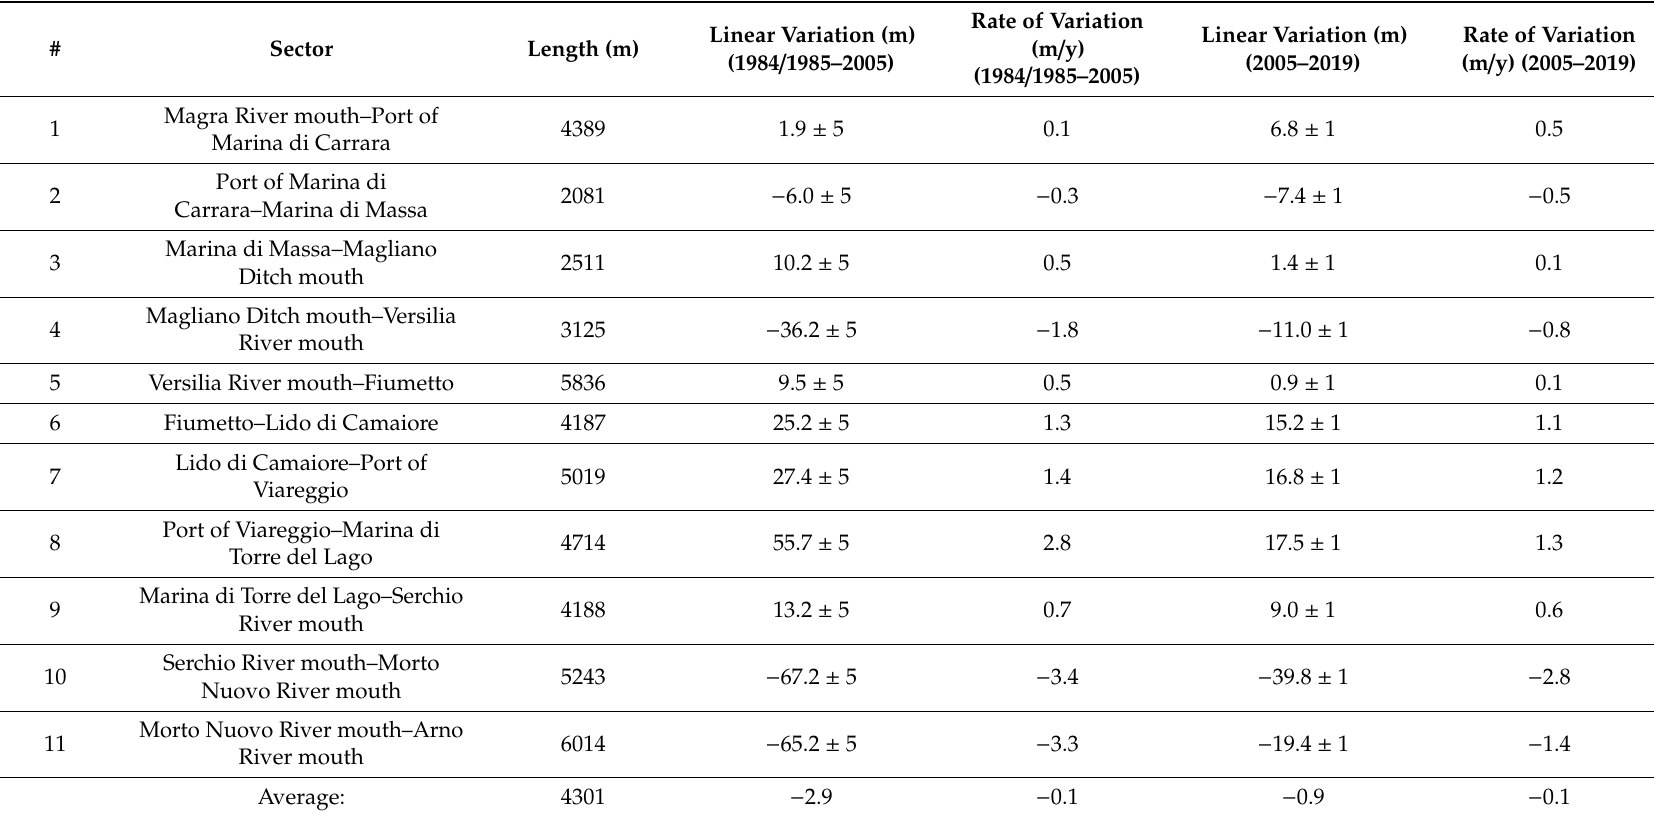
Table 7. Shoreline trends (linear variation and rate of variation) in the 13 sectors of the coast situated between the Magra River mouth and the Arno River mouth. Two time intervals have been taken into account: 1984 / 1985–2005 and 2005–2019. The uncertainty corresponds to the highest error of the surveys involved in both comparisons, that is ± 5 m for the 1984 / 85–2005 interval and ± 1 m for the 2005–2019 interval.